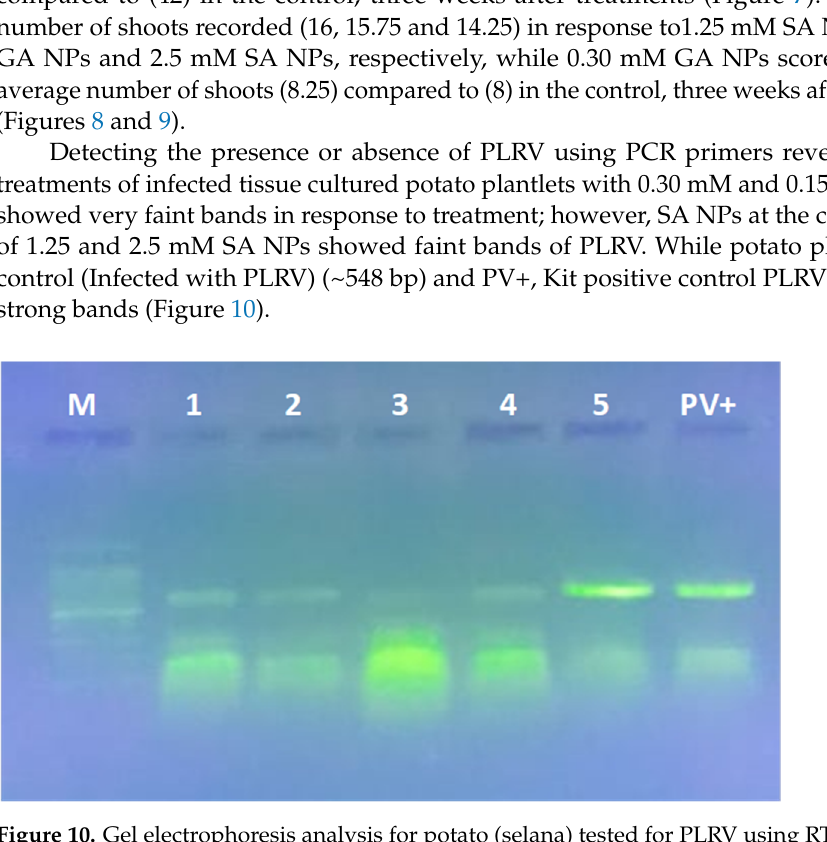
Figure 10. Gel electrophoresis analysis for potato (selana) tested for PLRV using RT-PCR utilizing specific PCR primers. Lane M 1 Kb DNA Marker. L1, infected potato plants with PLRV treated with Salicylic acid (1.25 mM), Lane 2, infected potato plants with PLRV treated with Salicylic acid (2.5 mM), Lane 3, infected potato plants with PLRV treated with glycyrrhizic acid ammonium salt (0.30 mM), Lane 4, infected potato plants with PLRV treated with glycyrrhizic acid ammonium salt (0.15 mM). Lane 5, Potato plants positive control infected with PLRV (~548 bp) Lane PV+, Kit positive control PLRV.